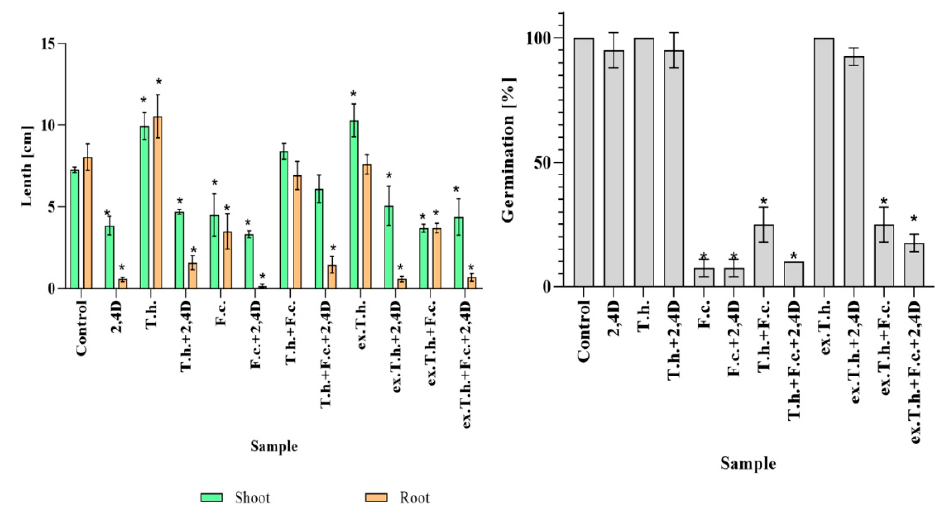
Figure 1. The total germination % values and the lengths of the seedlings measured after the 7th day of cultivation (T.h.— T. harzianum -inoculated wheat seeds; F.c.— F. culmorum -inoculated wheat seeds; ex.T.h.— T. harzianum extracellular metabolite-treated wheat seeds). Data represent means ± SE; the significance of the variance study with Tukey’s post hoc test = * p ≤ 0.001. The subcolumn statistic comparison is attached in supplementary material as Table S1.